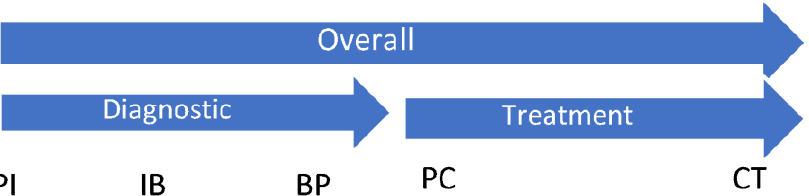
Figure 2. Study primary endpoints: Overall (presentation to initial treatment), Diagnostic (presentation to pathology), Treatment (pathology to initial treatment). Study secondary endpoints: PI (presentation to imaging); IB (imaging to biopsy); BP (biopsy to pathology); PC (pathology to specialist consult); and CT (consult to initial treatment).